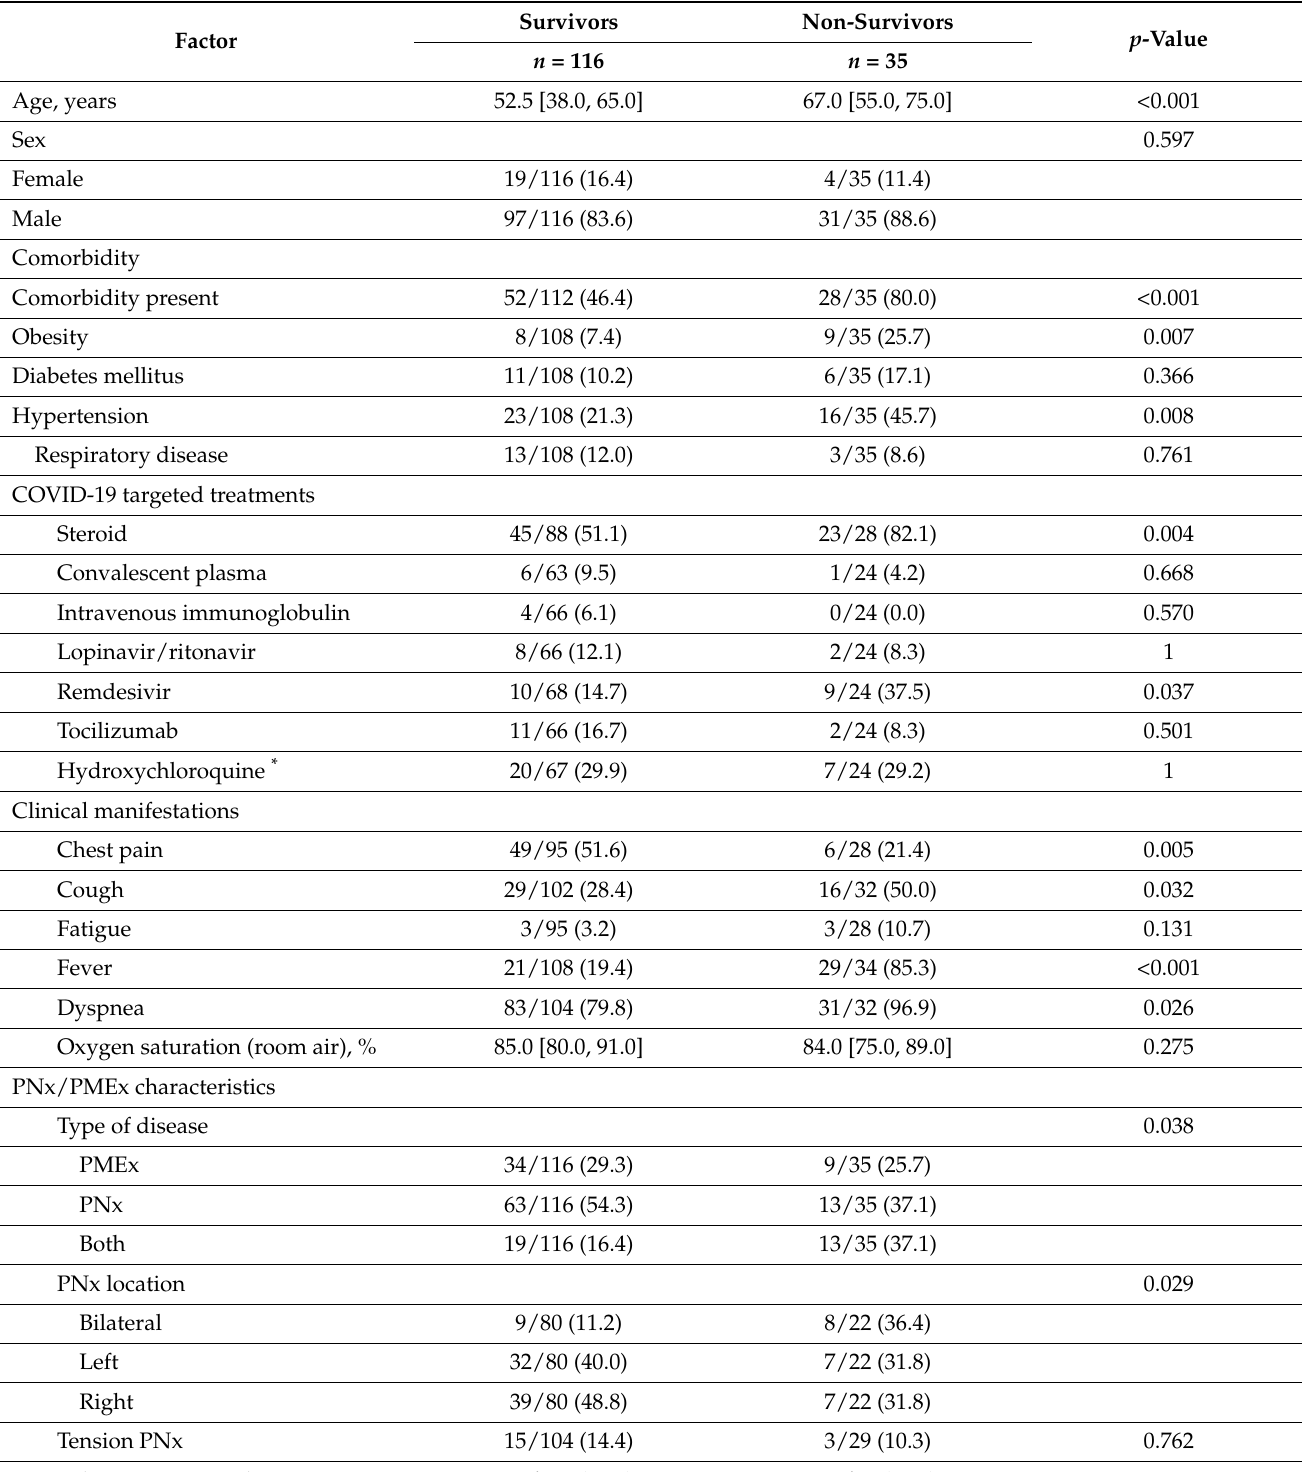
Table 2. Clinical characteristics and outcomes of patients with PNx/PMEx according to